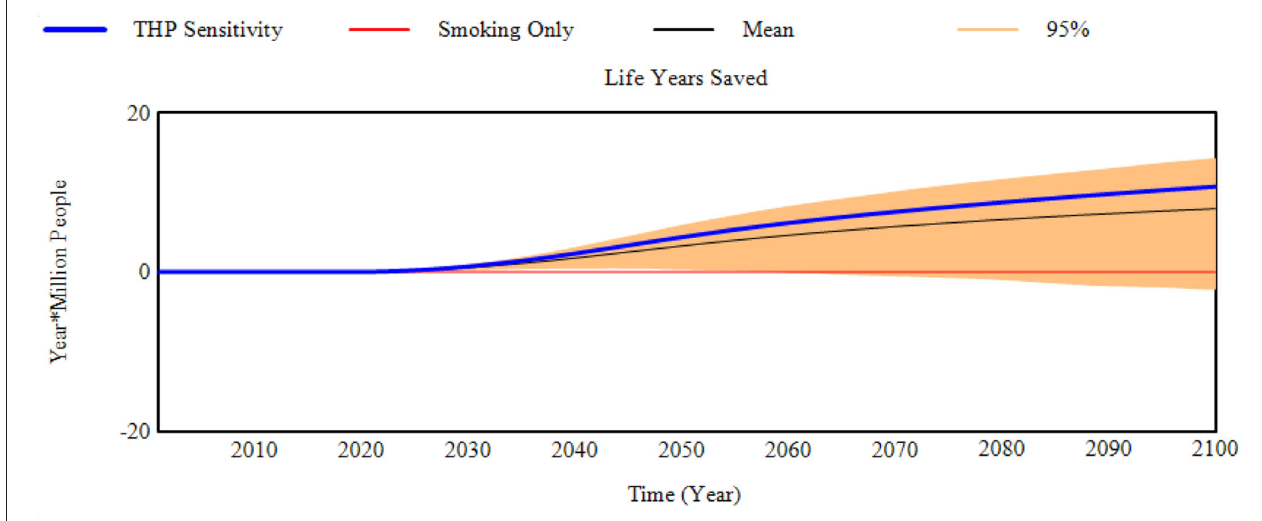
FIGURE 4 | Reduction in life years lost compared to the smoking only scenario (Life years saved) for the THP scenario sensitivity to transition probabilities.